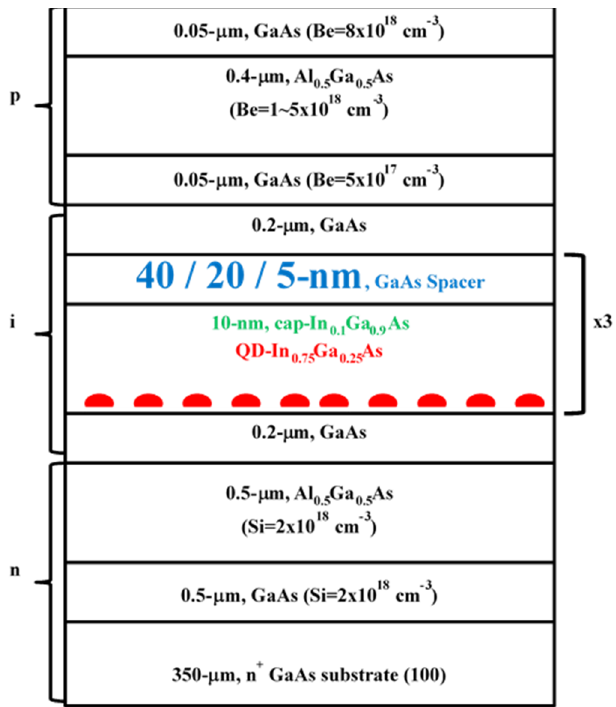
Figure 1. Schematic diagram of the p-i-n structure consisting of triple-layer In 0.75 Ga 0.25 As QDs.